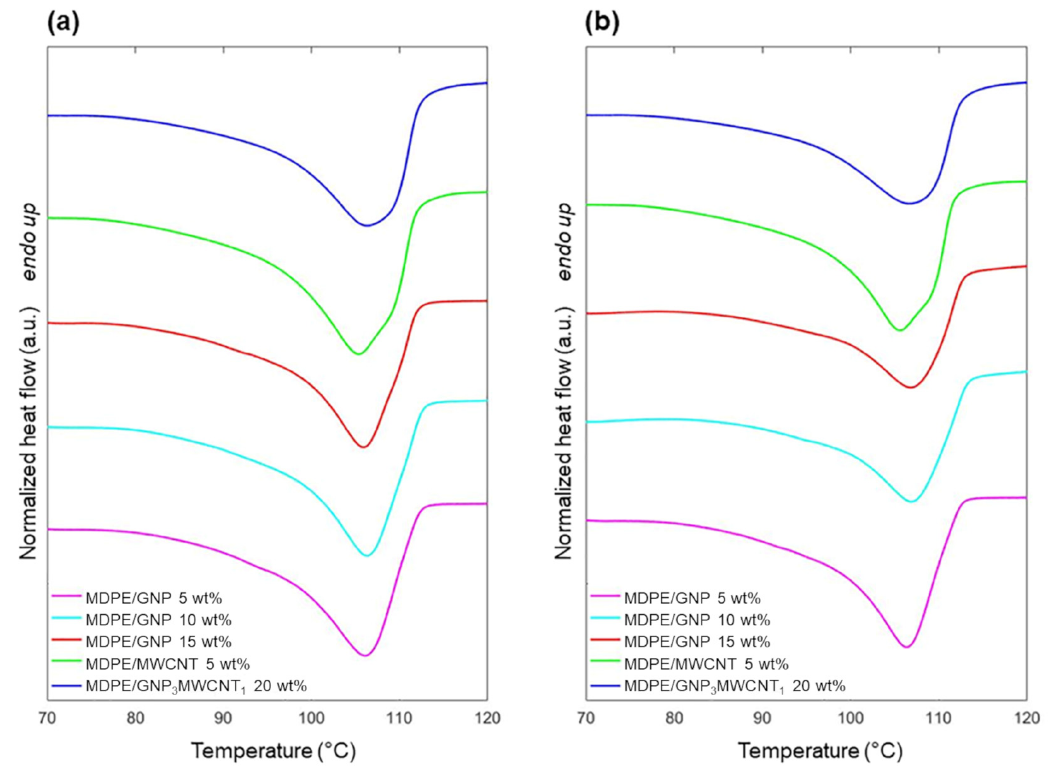
Figure 6. DSC thermograms upon cooling for MDPE/GNP 5 wt%, MDPE/GNP 10 wt%, MDPE/GNP 15 wt%, MDPE/MWCNT 5 wt% and MDPE/GNP 3 MWCNT 1 20 wt% nanocomposites ( a ) before and ( b ) after proton irradiation. Heating rate: 10 °C/min. Heat fl ow is normalized by the sample weight. Data are offset for clarity. Table 4. DSC results for MDPE/GNP and MDPE/MWCNT samples at different filler concentrations, and for the MDPE/GNP 3 MWCNT 1 20 wt% nanocomposite before and after proton irradiation. Standard deviation of data are below 2%.